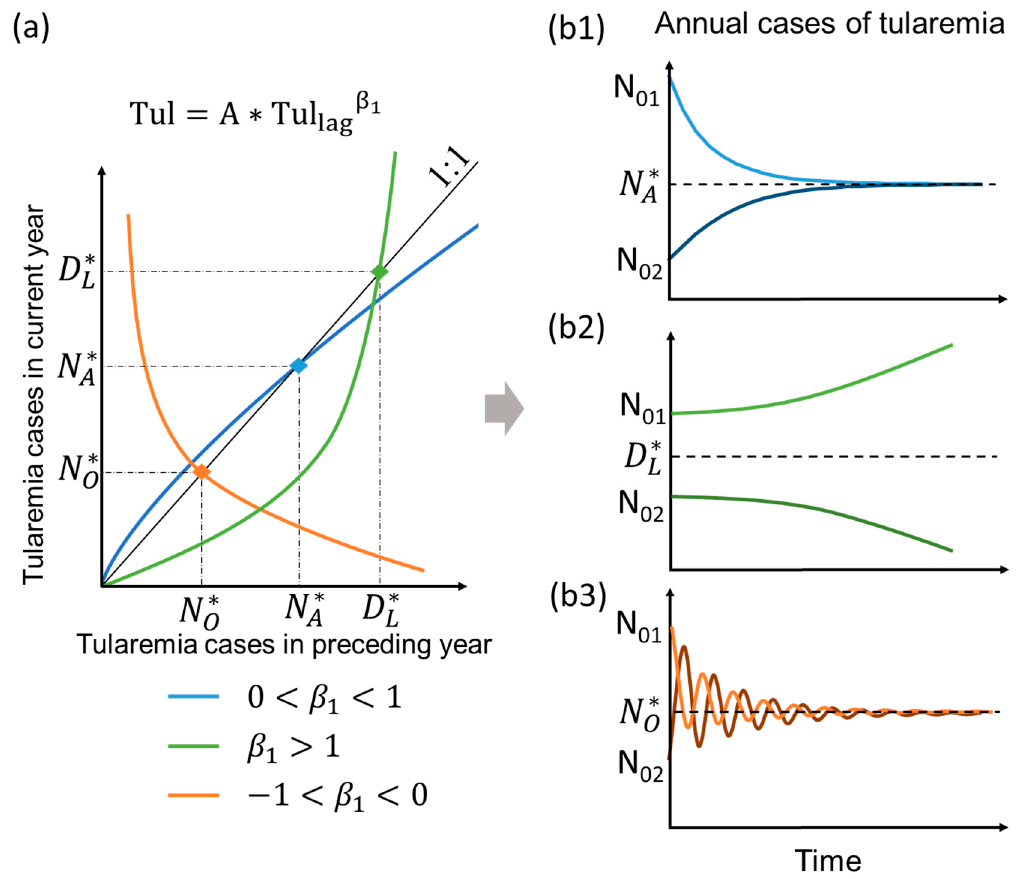
Figure 3. Conceptual diagram of: ( a ) different types of power-law scaling of number of tularemia outbreaks in a year (Tul) with the preceding-year number of outbreaks (Tul lag ); and ( b1 – b3 ) the associated evolution of Tul with time. The curve intersections with the black 1:1 line at Tul = Tul lag = N (cid:2885)∗ , D (cid:2896)∗ , N (cid:2899)∗ in ( a ) represent endemic convergence level (dashed line in ( b1 )), divergence level (dashed line in ( b2 )), and endemic convergent oscillation level (dashed line in ( b3 )), respectively, for Tul after a shift in long-term average hydroclimatic conditions from a initial Tul lag level larger (N 01 ) or smaller (N 02 ) than N (cid:2885)∗ , D (cid:2896)∗ , N (cid:2899)∗ (i.e., in A of the best-fit power-law scaling 𝑇𝑢𝑙 = 𝐴 ∗ 𝑇𝑢𝑙 (cid:3039)(cid:3028)(cid:3034)(cid:3081) (cid:3117) for different exponent 𝛽 (cid:2869) cases of relevance for the Swedish study counties (Table 1).